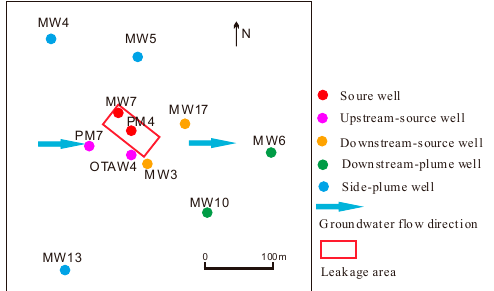
Figure 1. Diagram showing the petroleum-contaminated area, the monitoring wells, and the groundwater flow direction.